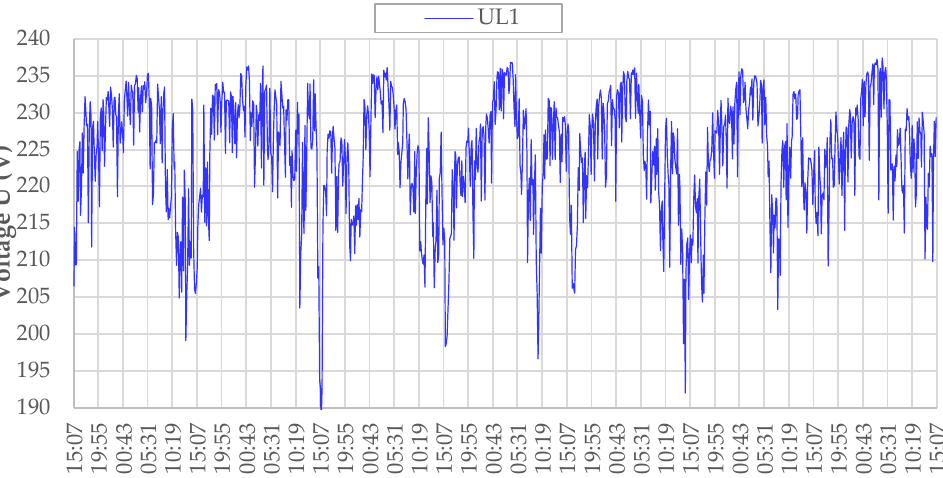
Figure 14. Voltage measurements according to standard EN 50160 at Object 1 (1 phase, average of 10-min intervals).